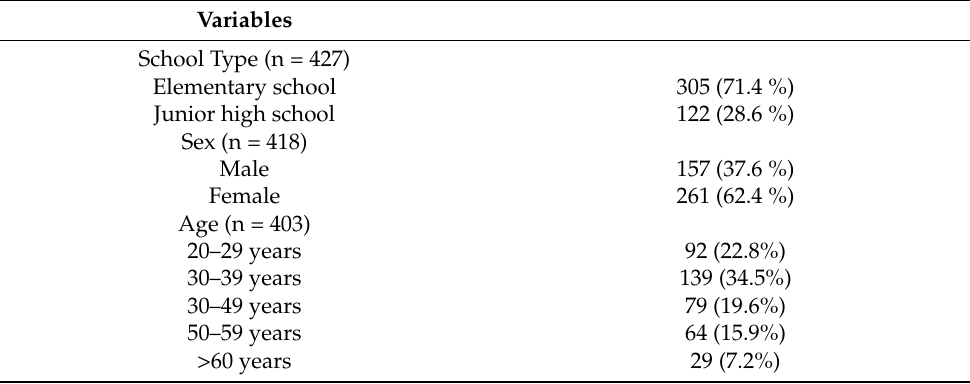
Table 1. Participants’ characteristics